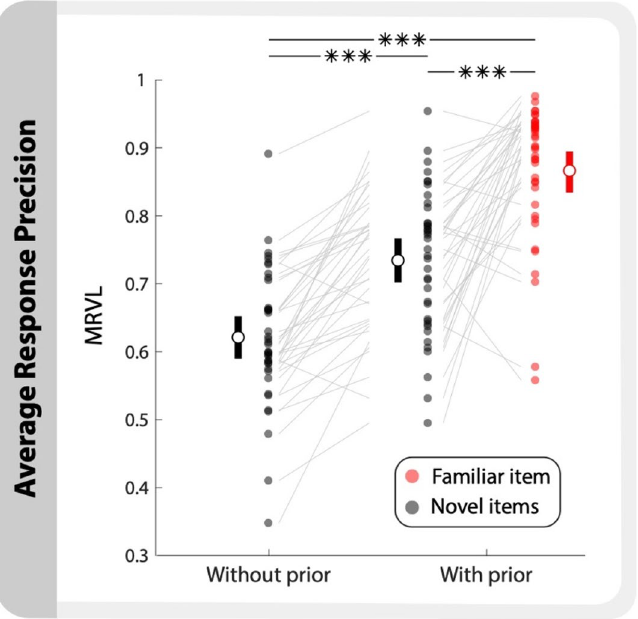
Figure 2. Greater response precision when prior information is known. Response precision (MRVL) with and without the prior information for both the familiar and novel items. White circles indicate group mean; bars indicate bootstrapped 95% CIs. Dots and lines represent individual participants. (*** p <